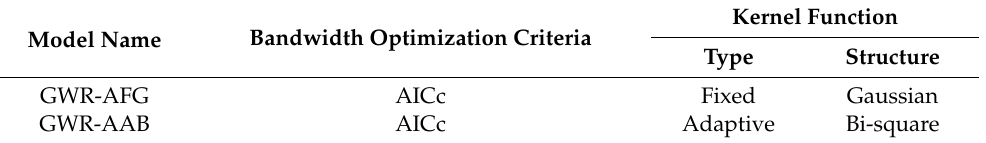
Table 2. The definition of GWR-AAB and